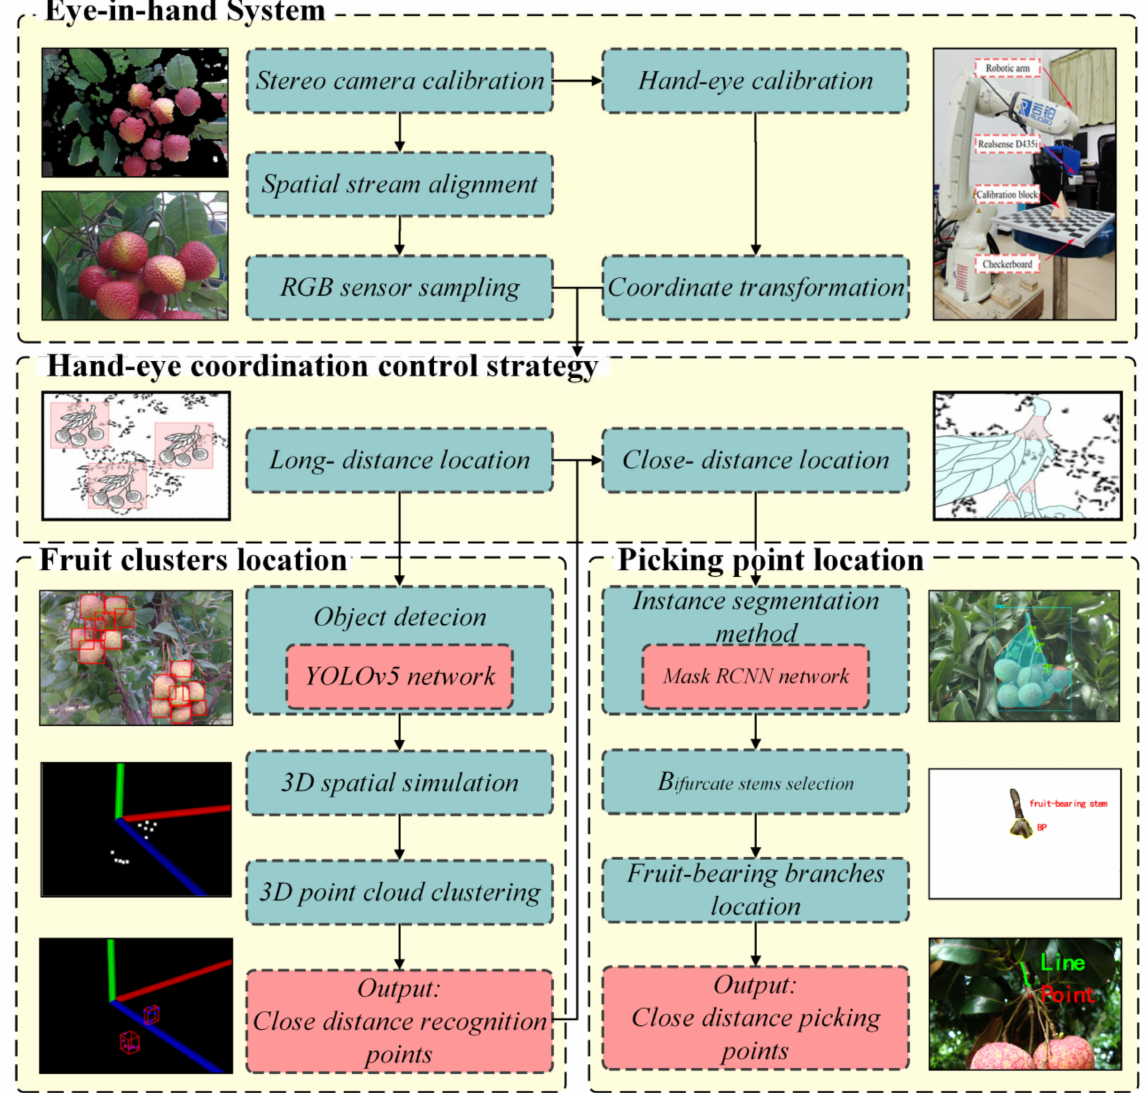
Figure 1. Litchi-picking robot